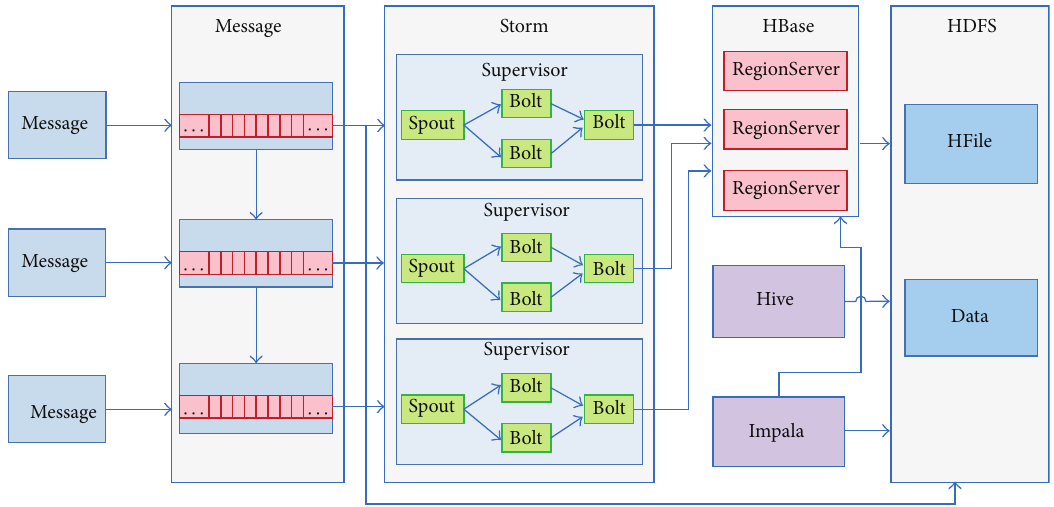
Figure 4: The cloud architecture in the X73 uHealth system.